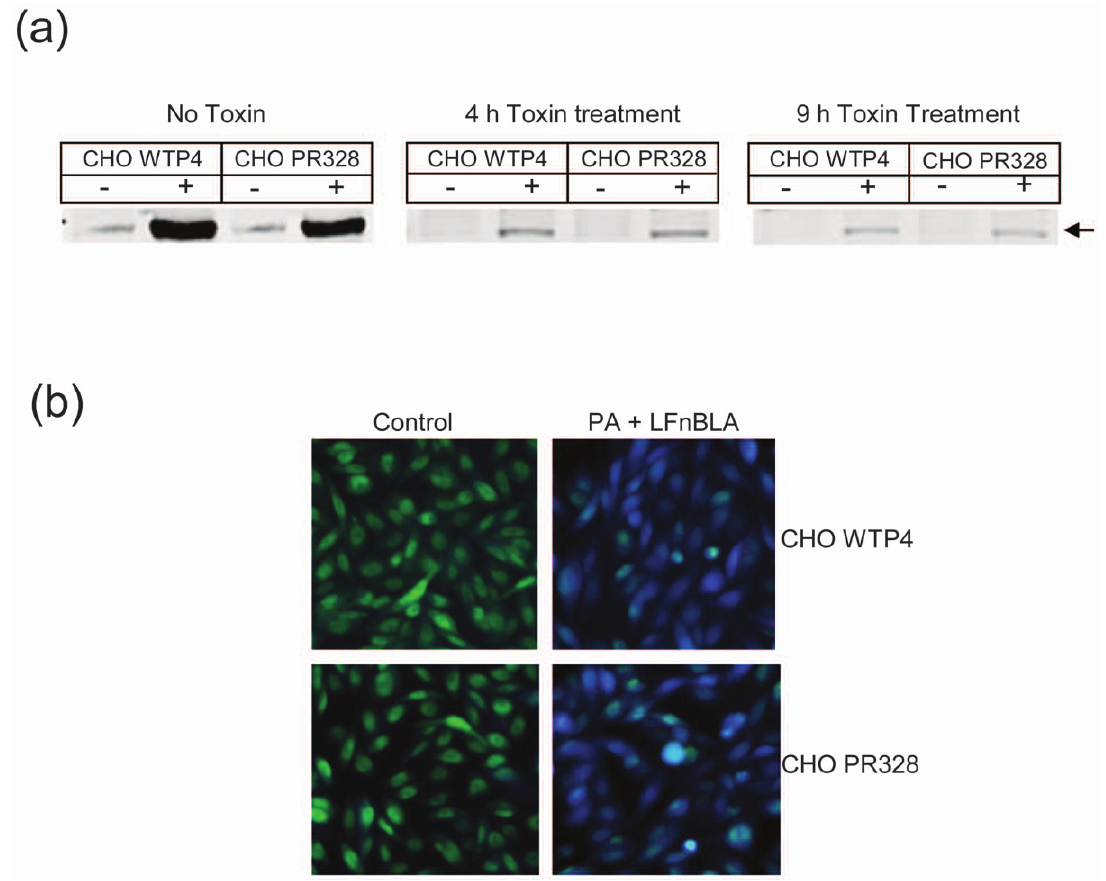
Figure 2. Toxin internalization in CHO PR328 cells. ( A ) Cells were treated with PA and FP59 (1 m g/ml each) for 1 h. Then toxin was replaced with fresh media after three washes with fresh medium, and incubated an additional 3 h or 8 h. At the end of desired incubation, cell lysates were prepared and tested for DT-induced ADP-ribosylation in vitro using biotin-NAD. Equal amounts of protein were then separated by SDS-PAGE followed by western blotting with streptavidin conjugated to Alexa Fluor dye and membrane was scanned on an Odyssey Infrared Imager. Left panel shows the control cells that did not receive treatment with PA + FP59. Middle panel shows the data with cells treated with PA + FP59 for 4 h (1 h treatment + additional 3 h) while right panel is for cells treated with PA + FP59 for 9 h (1 h treatment + additional 8 h). – and + denote the absence or presence of DT during the in vitro ADP-ribosylation reaction. Arrow indicates the biotin-ADP-ribose-eEF-2. ( B ) Cells were treated with PA and LFnBLA (1 m g/ml each) for 1 h. Thereafter, 1.5 m M CCF2/AM was added to the cells for 1 h at room temperature. The CCF2/AM remaining in the medium was removed by washing and cells were incubated an additional 1 h at room temperature to allow for CCF2/AM hydrolysis. The cells were then photographed with a fluorescence microscope using an excitation wavelength of 405 nm and emission filters of 530 nm (green light) and 460 nm (blue light). Beta- lactamase activity in treated cells is demonstrated by the blue fluorescence while control cells show green fluorescence.